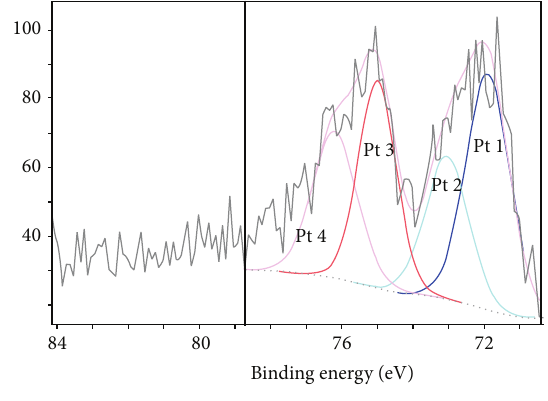
Figure 5: XPS analysis for Pt